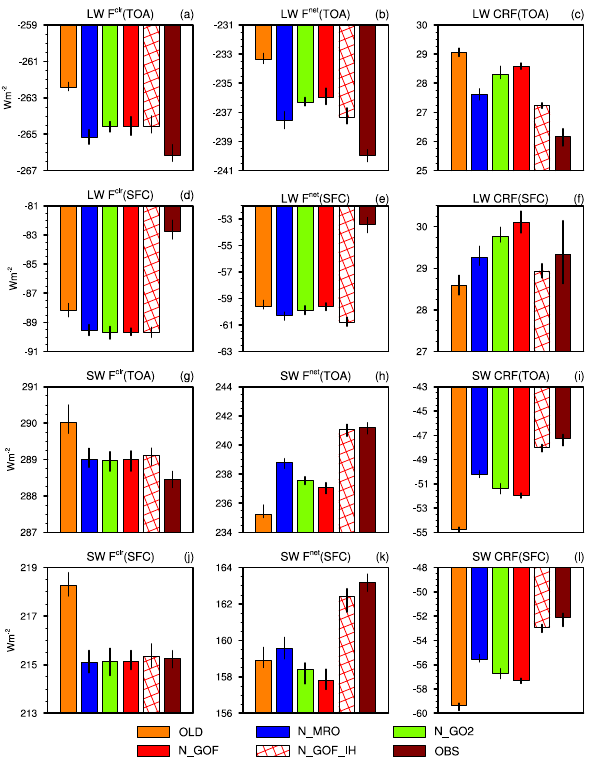
Fig. 1. Global annual mean clear-sky net fluxes ( F clr , left panels), all-sky net fluxes ( F net , central panels), and CRFs (right panels) for TOA LW (upmost row), surface LW (second row), TOA SW (third row), and surface SW (bottom row) from the various simulations and CERES_EBAF observations. The error bars are the ranges be- tween the maximum and minimum annual mean values for the sim- ulated or observed decades.